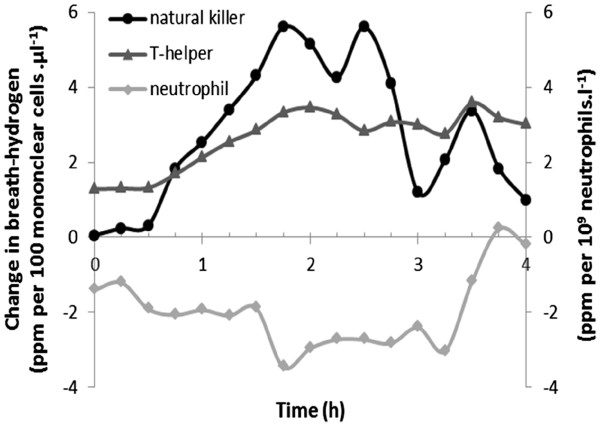
Relationship between breath-hydrogen concentration and blood leukocyte subsets over time after lactulose administration. Average increase in breath-hydrogen over baseline (343 tests; 15 min sampling intervals over 4h) is standardised for leukocyte count. Test positivity in the first 2h was associated with higher natural killer and T-helper mononuclear counts, lower neutrophils. Subsequently, breath-hydrogen was associated with T-helper count, tended to be with natural-killer (3 (95% CI 0, 4) & 5 (0, 11) ppm per 100 cell.μl-1 increment, respectively, p=0.02 & 0.06), but was not associated with neutrophil.